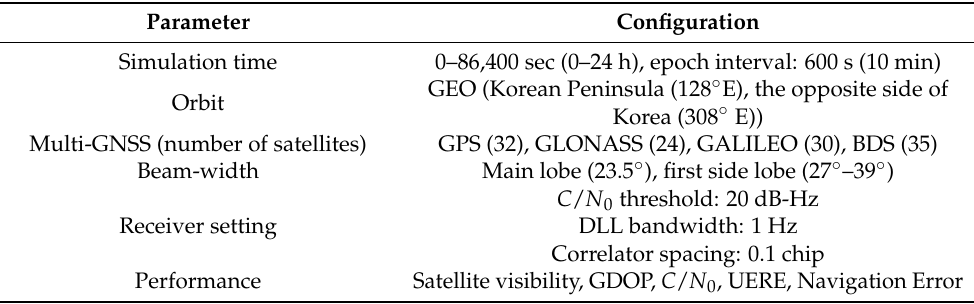
Table 1. Simulation parameter